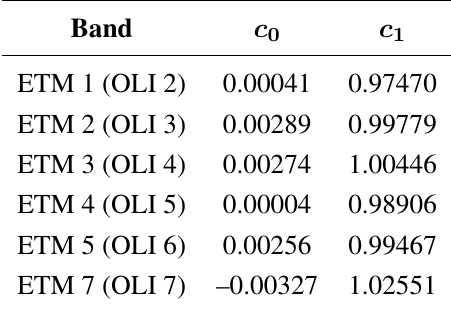
= c + c ρ . ETM+ 0 1 OLI